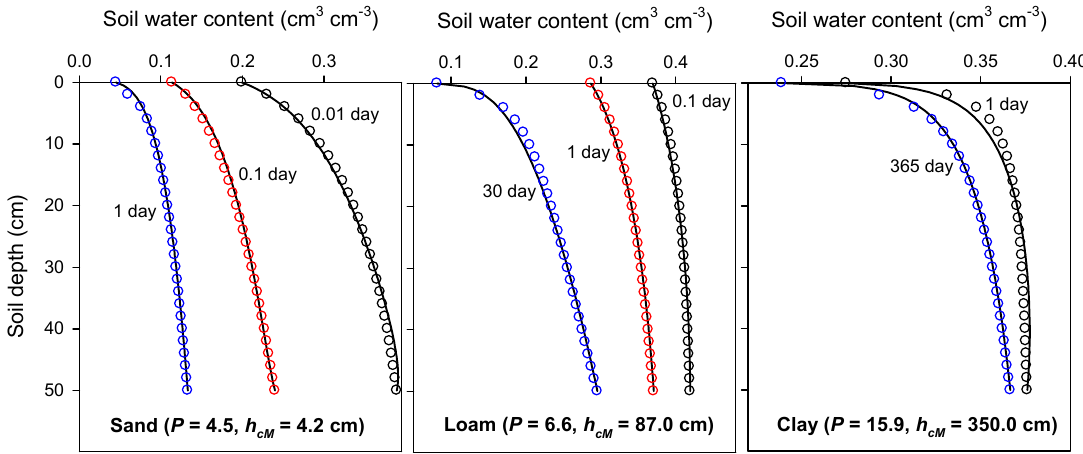
Figure 2. The best fit of Equation (21) (solid lines) to HYDRUS-1D simulation results (circles) for evaporation in the presence of a shallow water table at z = 1 m for three different soil textures.